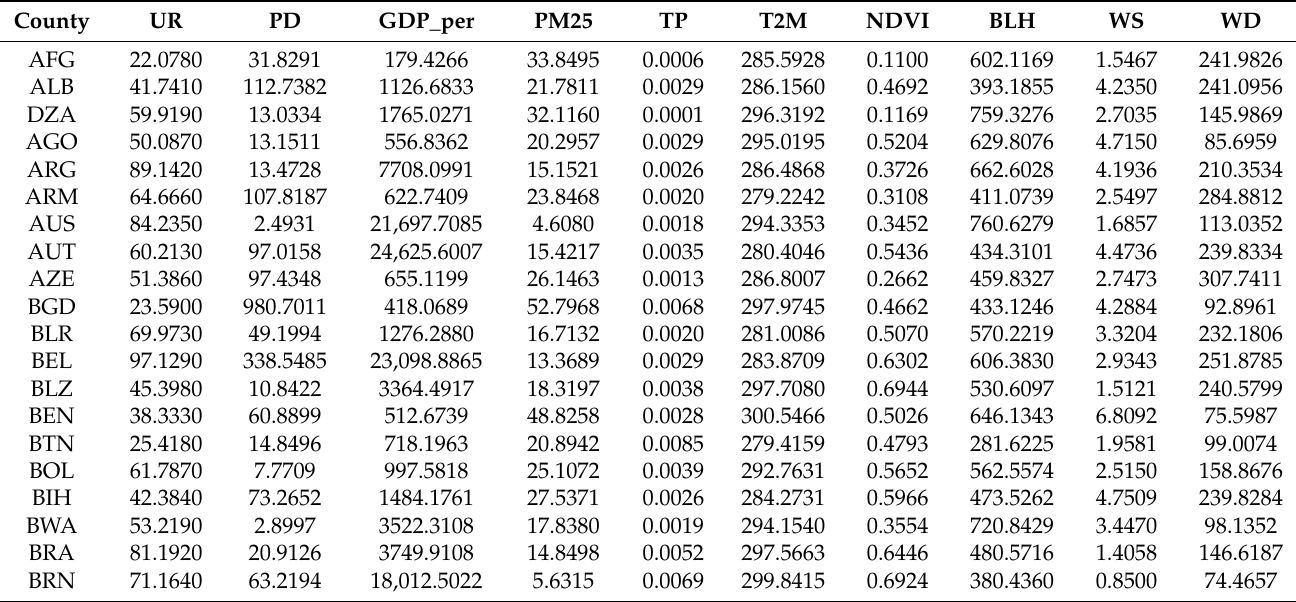
Table A1. Year-wise mean value of all the parameters in